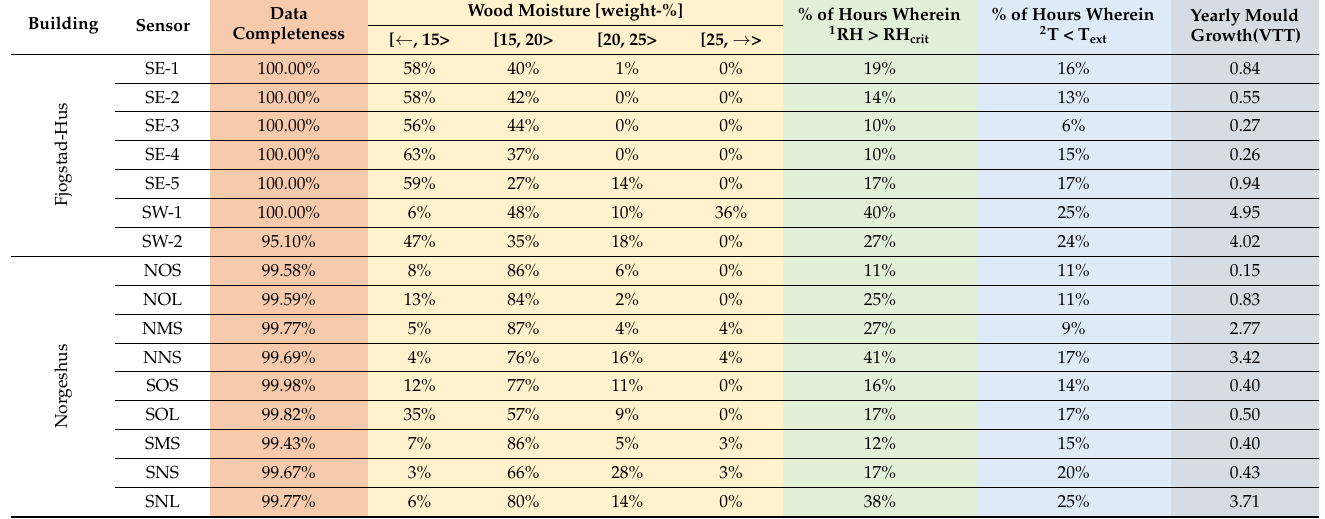
Table 6. A share of measurements [%] exceeding various criteria for mould growth for every sensor. The VTT parametric study results for each sensor are also shown in the right column. The analyses are separated by colour for